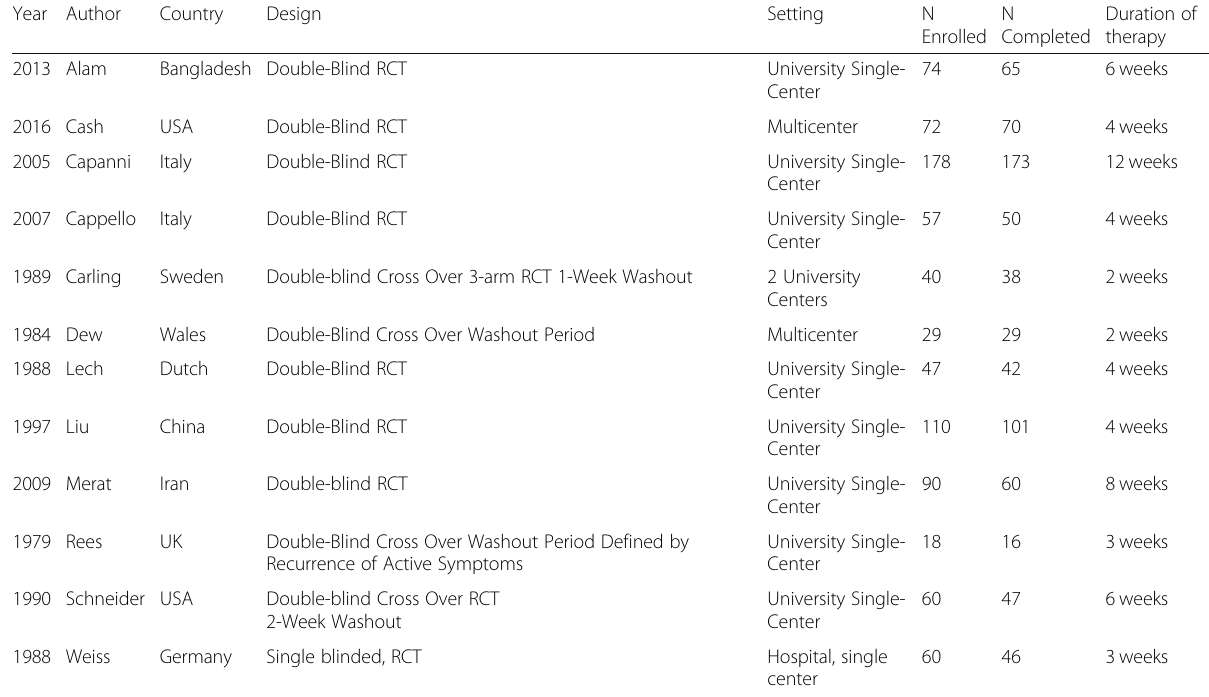
Table 2 Characteristics of Included